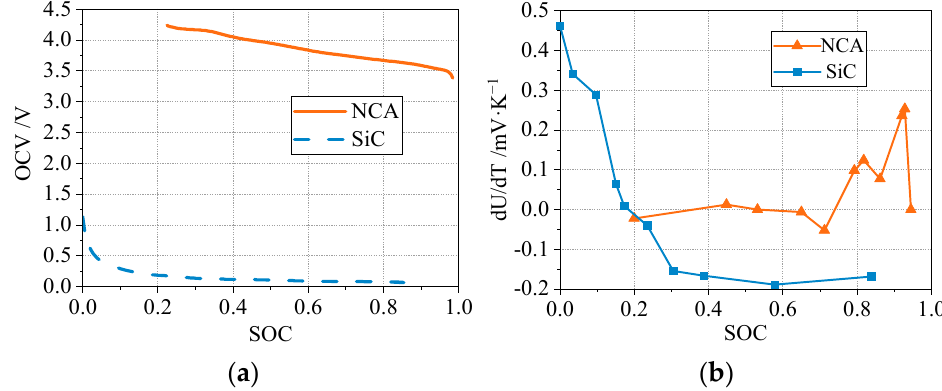
Figure 3. Thermodynamic parameters at different SOC: ( a ) open-circuit voltages and ( b ) the entropic coefficient.